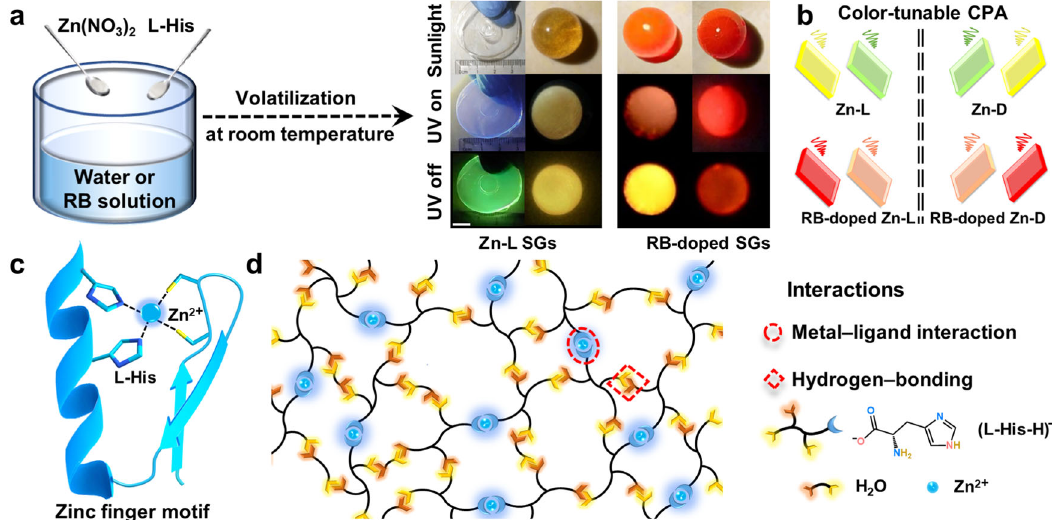
Fig.1|SchematicillustrationofZn – LSGsfabrication.a PreparationofZn – Land RB-doped SGs(RB:Rhodamine B), and photos of the obtained Zn – L and RB-doped SGs in the shape of a sphere and/or a round sheet taken under the sunlight, and